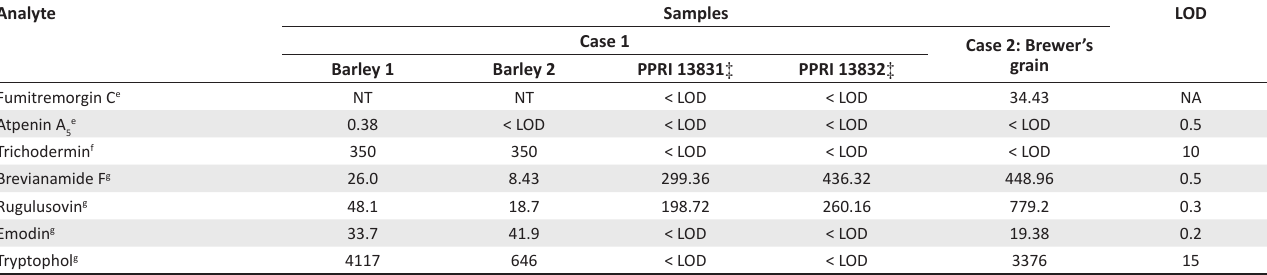
TABLE 1 (Continues...): Fungal metabolites and estimated concentrations ( μ g/kg) in feed samples and Aspergillus clavatus isolates.